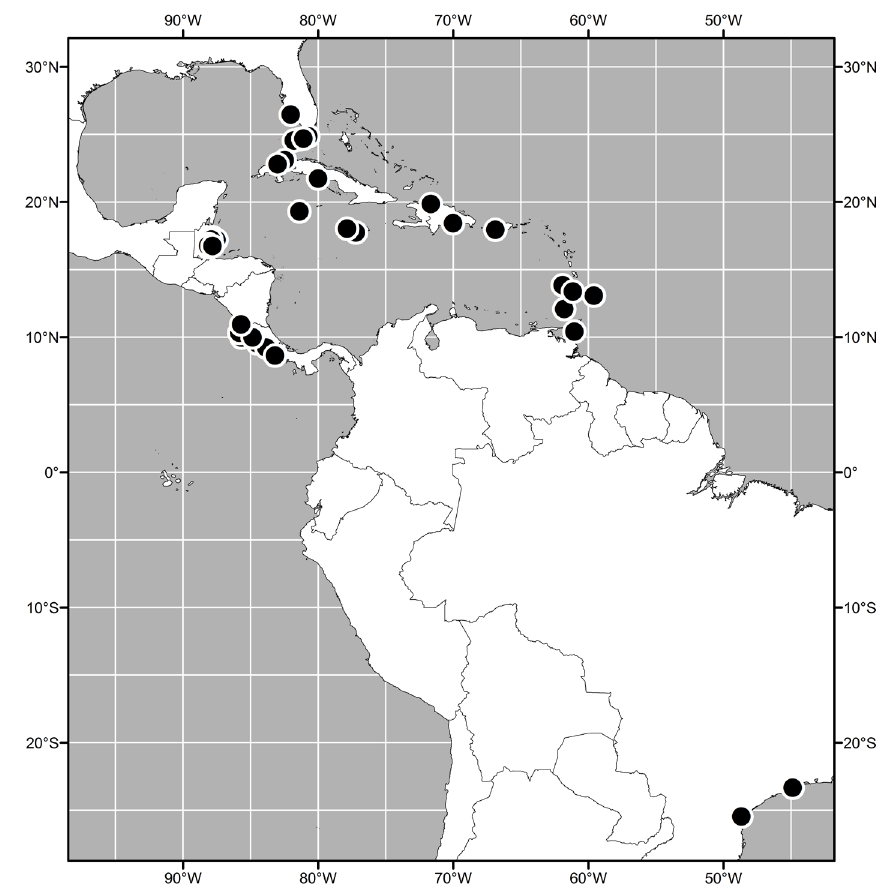
Figure 16. Distribution map for Orasiopa ( Reymontopa ) mera